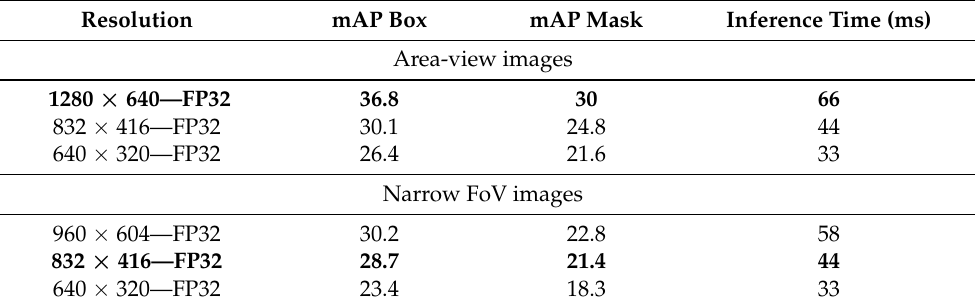
Table 2. Evaluation of the instance segmentation network on area-view images corresponding to front, left, back, right views and narrow FoV images on the front view. Inference time is measured on a single image. The bolded configuration is integrated in the final